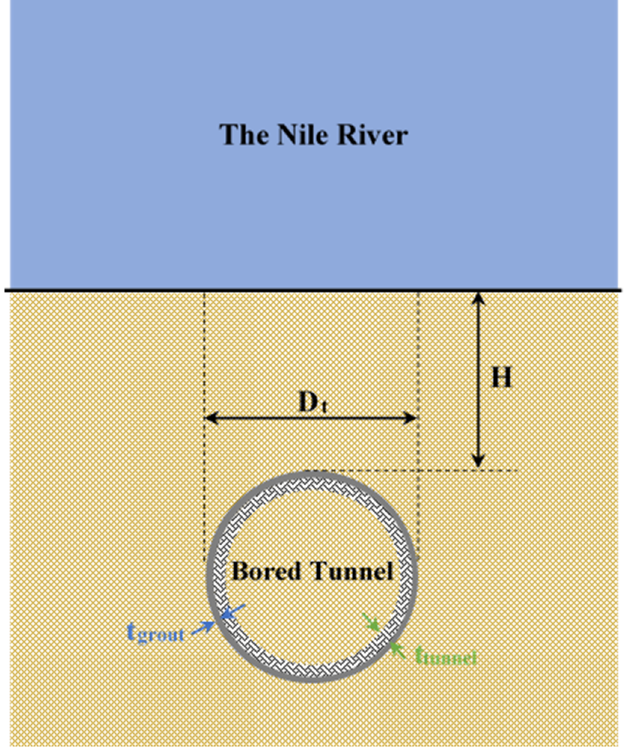
Figure 7. Sketch of the bored tunnel under the Nile River. To satisfy the general stability condition, three stages during construction and one case during service are necessary, as per Figure 8.